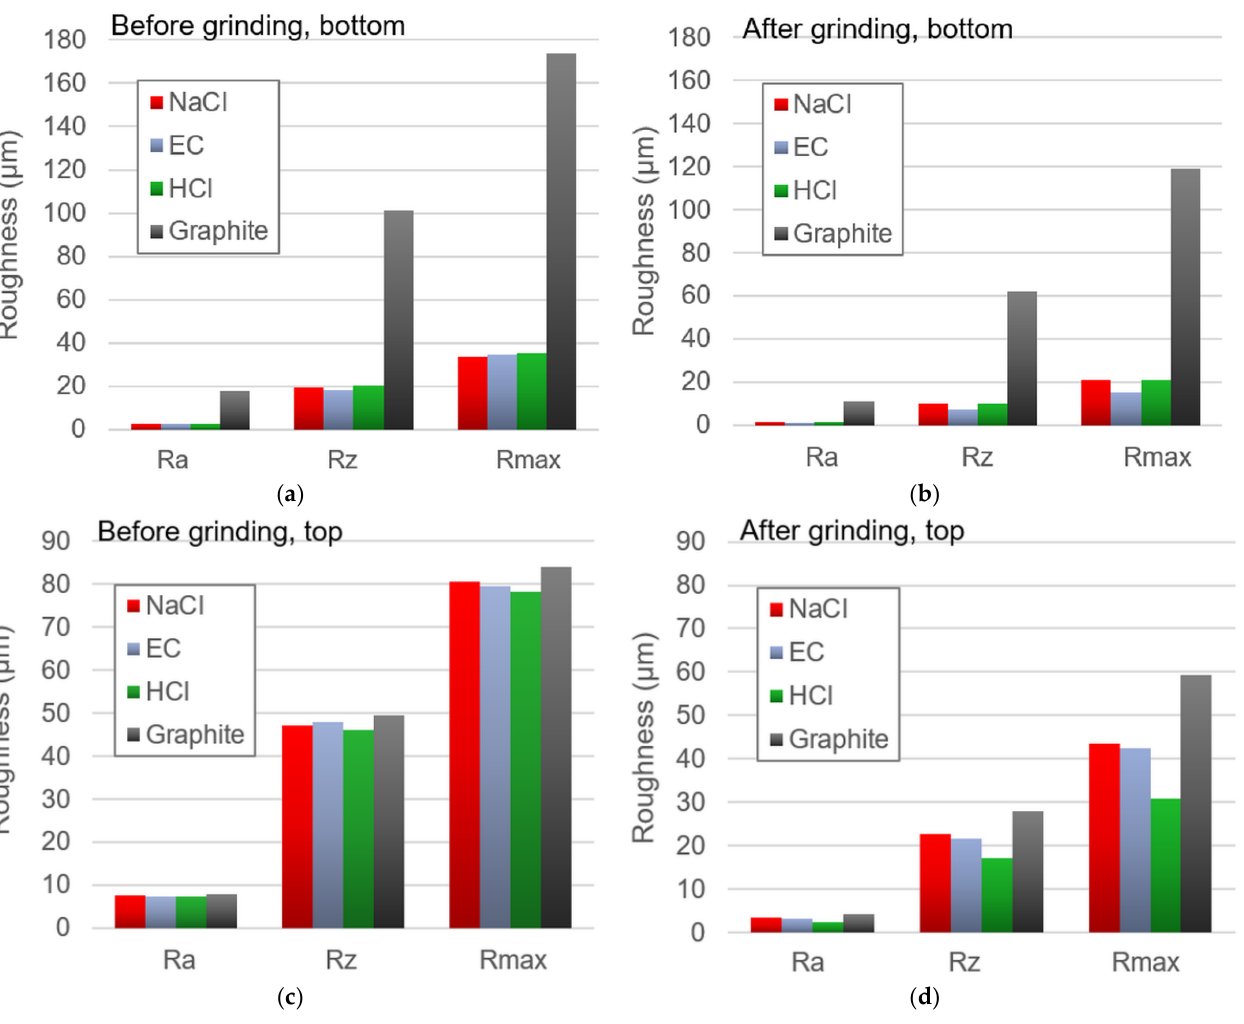
Figure 5. Roughness values of the free-standing coatings before ( a , c ) and after grinding ( b , d ). ( a – d ) show the roughness of the bottom surface, which was in contact with the substrate, and the top surface of the coatings, respectively.